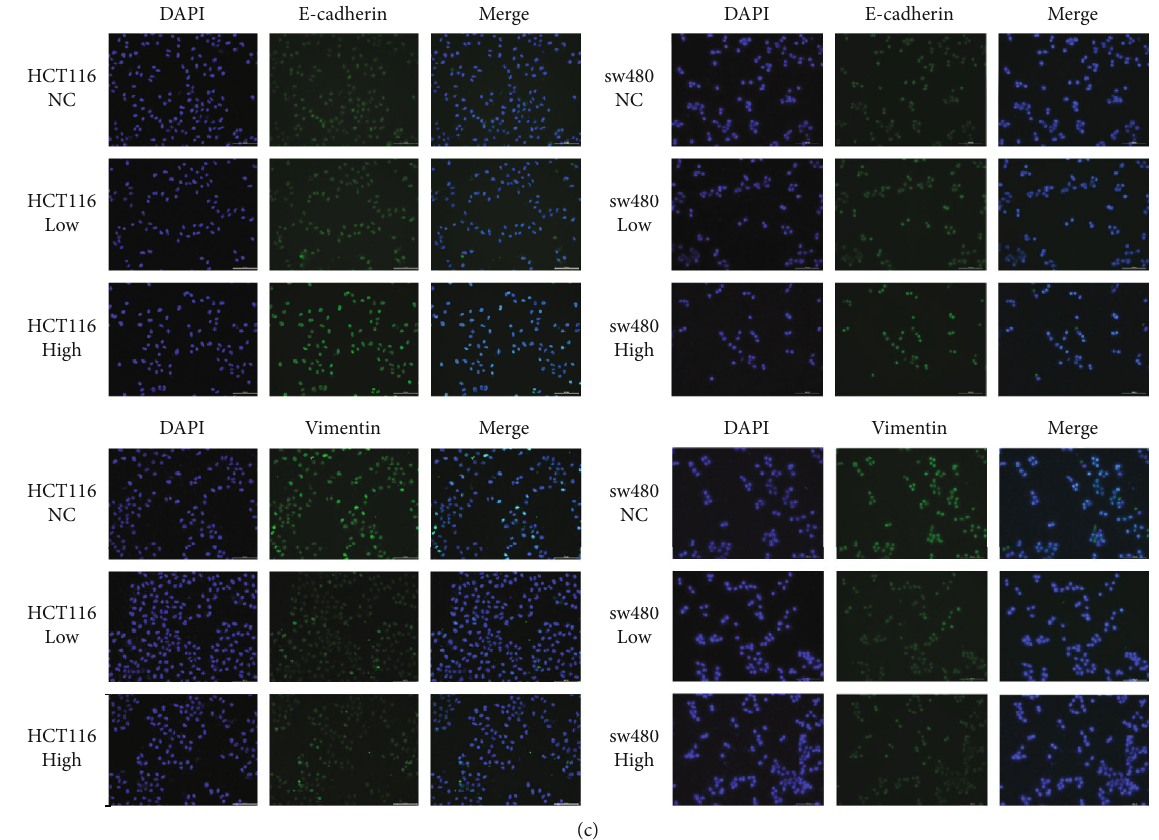
Figure 4: Feno fi brate inhibited cell migration and EMT. (a) Wound healing assay for demonstrating the inhibitory e ff ect of feno fi brate on the migration of colon cancer cells at 0, 24, 48, and 72 h following wounding. (b) The mRNA and protein expression levels of E-cadherin, vimentin, and MMP9 were measured following feno fi brate treatment. Data was presented as mean ± SD ( ∗ P < 0 : 05 , ∗∗ P < 0 : 01 , ∗∗∗ P < 0 : 001 ). (c) The expression of E-cadherin and vimentin in colon cancer cells was examined using immuno fl uorescence staining (magni fi cation